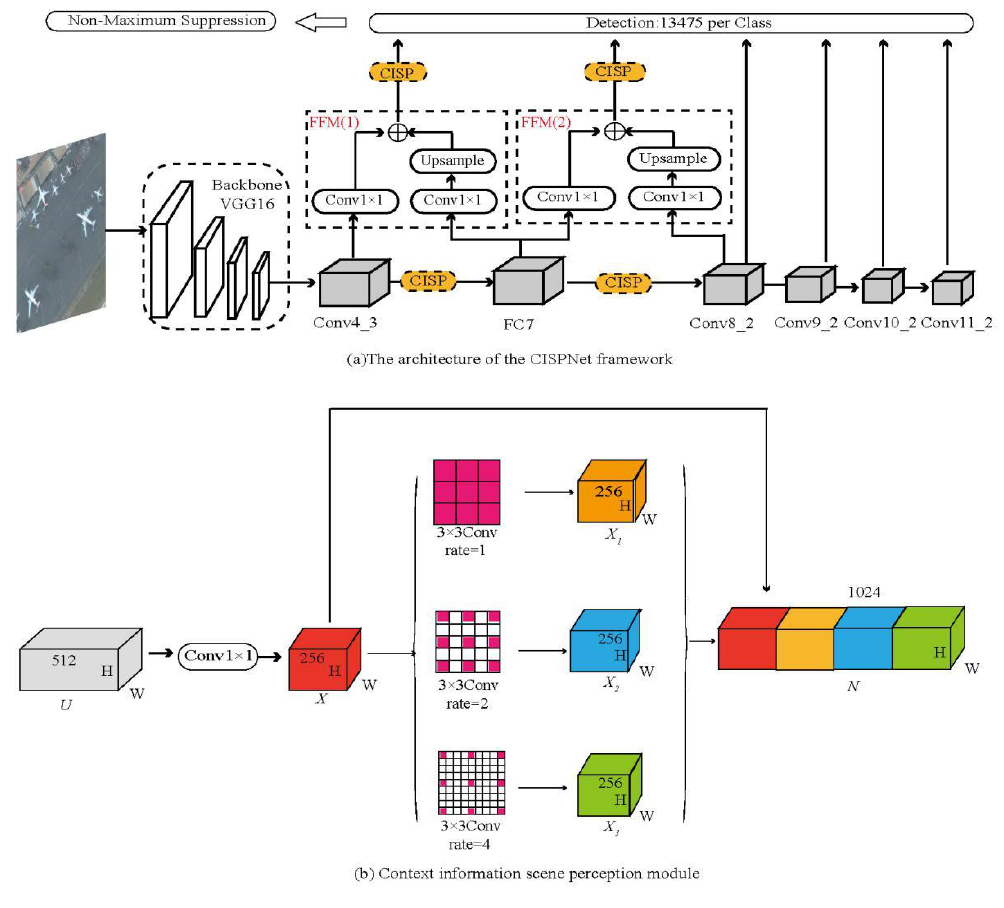
Figure 3. The architecture of CISPNet and its novel module CISP. ( a ) The architecture of the CISPNet framework; ( b ) The layer settings of the CISP module, where each box represents a conv + bn + relu group.